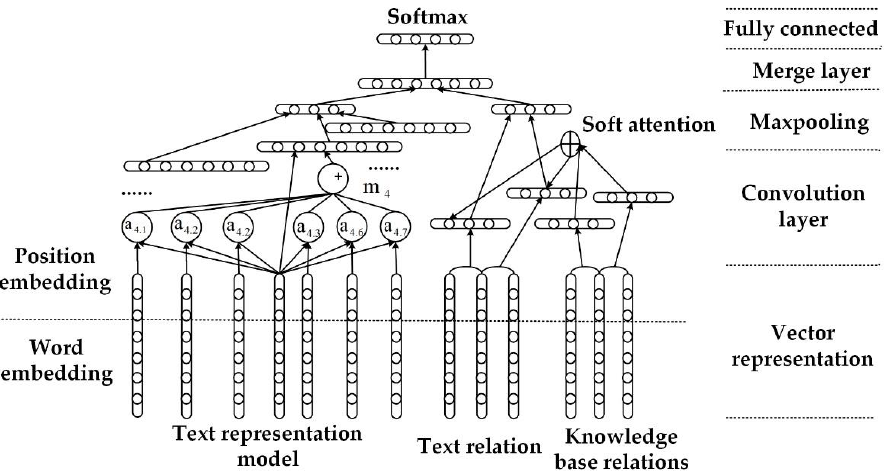
Figure 3. The architecture of the dual CNN, includes an input layer, a convolutional layer, a pooling layer, a merging layer, and a fully connected layer [20].